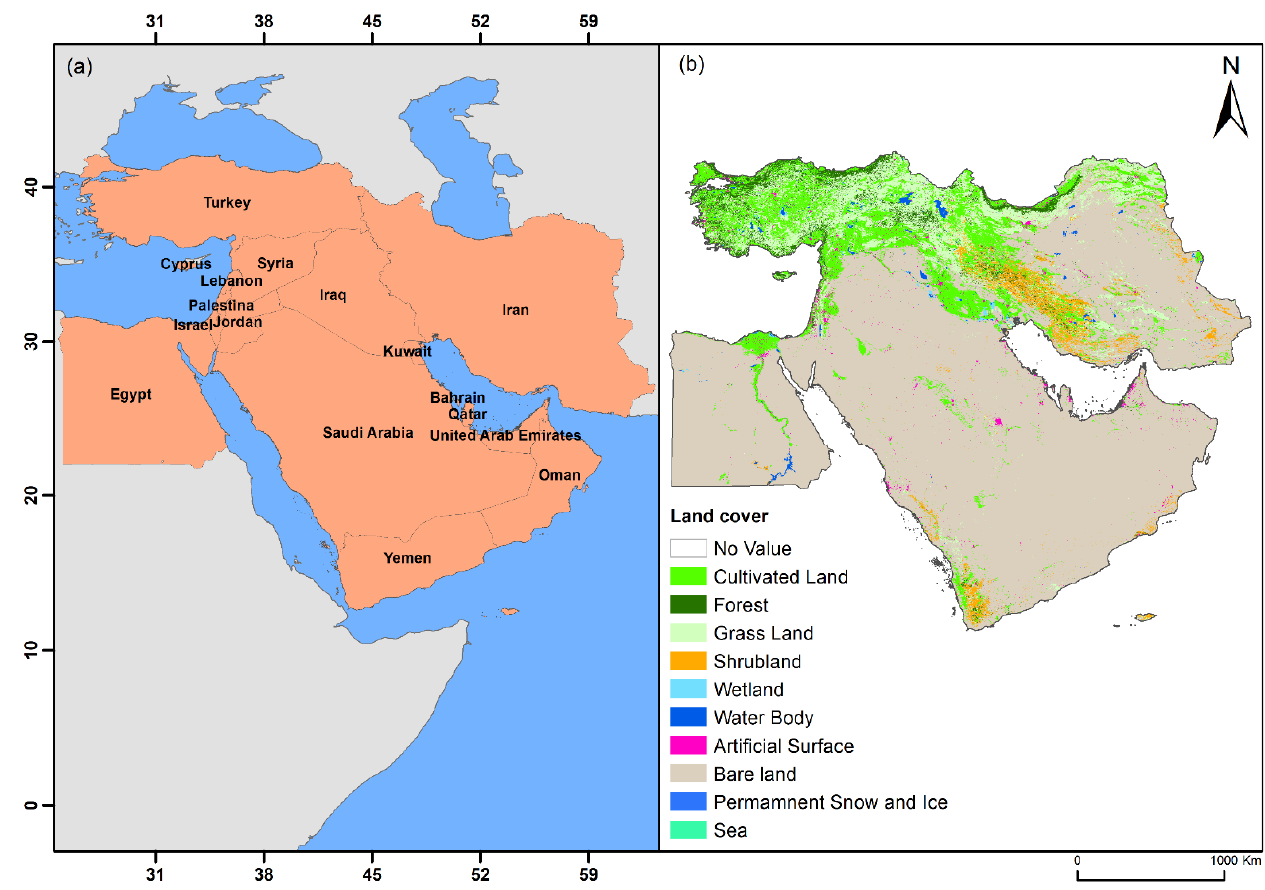
Figure 1. Maps of ( a ) country boundaries of the study area [78] and ( b ) land cover type with a spatial resolution of 30 m for 2020 [77].